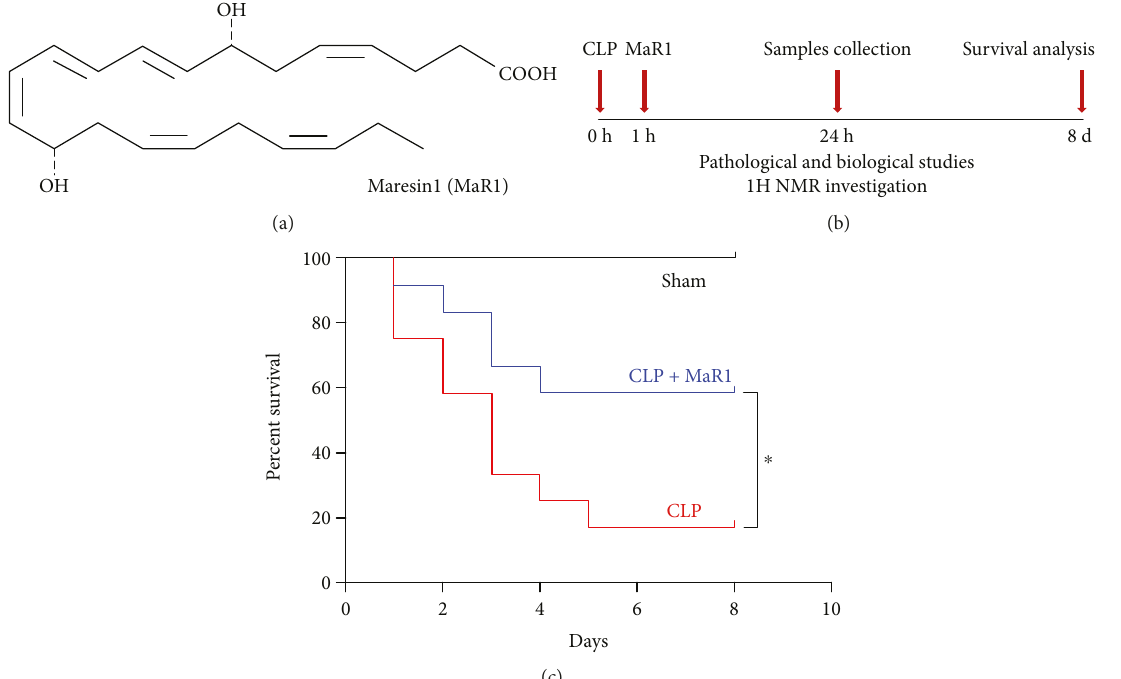
Figure 1: MaR1 improved the survival rate of mice in cecal ligation and puncture- (CLP-) induced septic model (a); the chemical structure of MaR1 (b); experimental schedule (c). MaR1 (100ng/mice, i.p.) was administered to C57BL/6 mice 1h after surgery, and an equal volume of saline was given in both the sham and CLP groups. The survival rate was observed for 8 days. Survival of the two subgroups was estimated by Kaplan – Meier survival curves; comparisons were performed by the log-rank test ( n = 12 ), ∗ P < 0 05